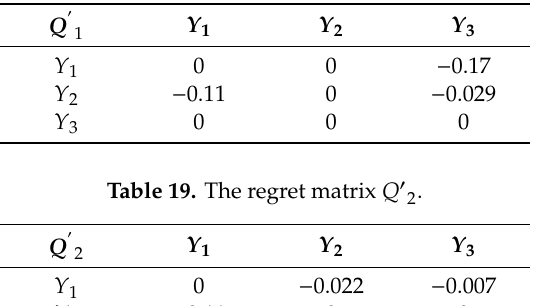
Table 18. The regret matrix Q (cid:48) 1 .